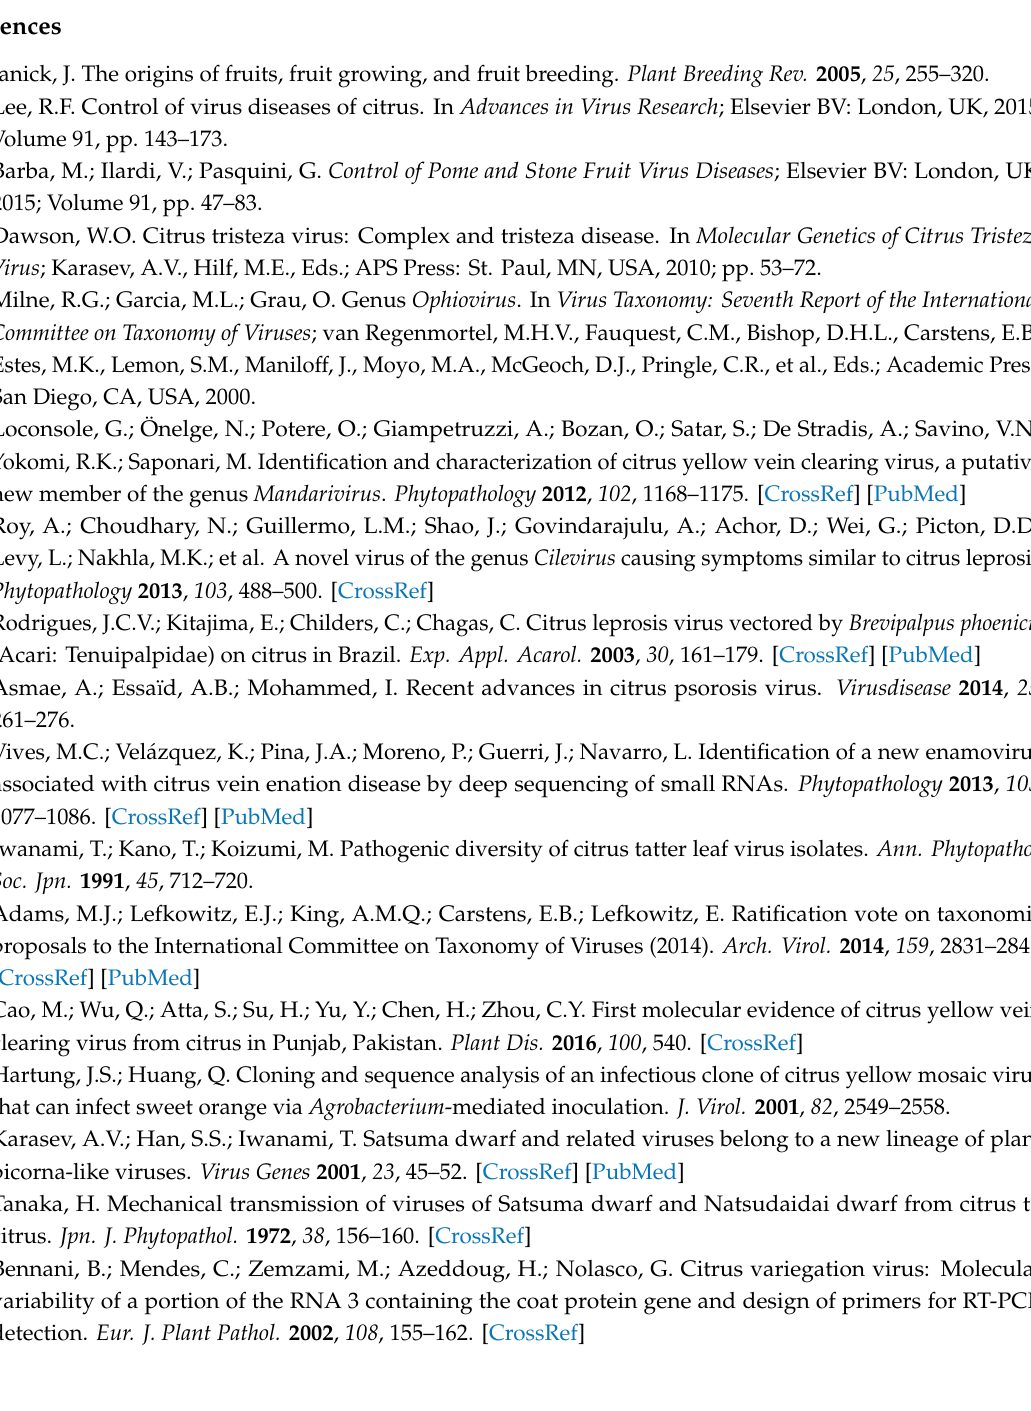
Table S1: Viruses infecting citrus trees, Table S2: Viruses infecting pome fruit trees, Table S3: Viruses infecting stone fruit trees; Table S4: Viruses infecting grapevine trees, Table S5: Viruses infecting banana trees, Table S6: Summary of the viruses infecting fruit